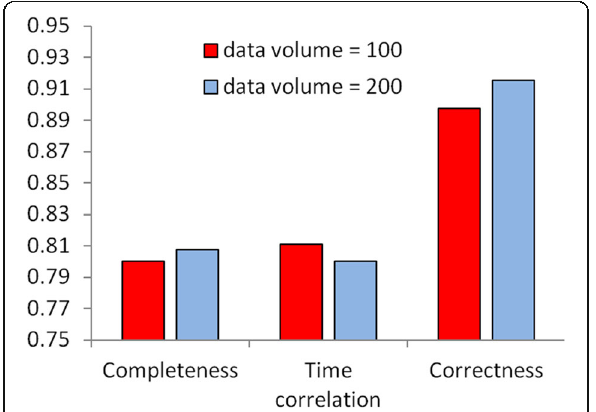
Fig. 4 The effect of data volume on other